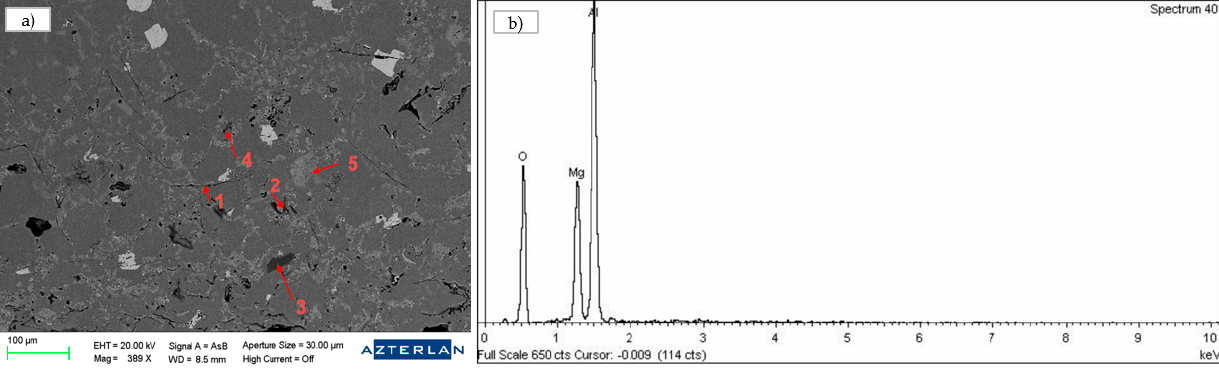
Figure 7. ( a ) Microinclusion identification using SEM analysis of the primary alloy before the melt treatment: (1) oxides films γ -Al 2 O 3 ; (2) carbides Al 4 C 3 ; (3) large magnesium oxides and spinel MgAl 2 O 4 ; (4) oxides and others ( α -Al 2 O 3 , CaO, and SiO 2 ); (5) grain refinement particles TiB 2 and (Ti, V)B 2 ; ( b ) EDS analysis of the main oxide.